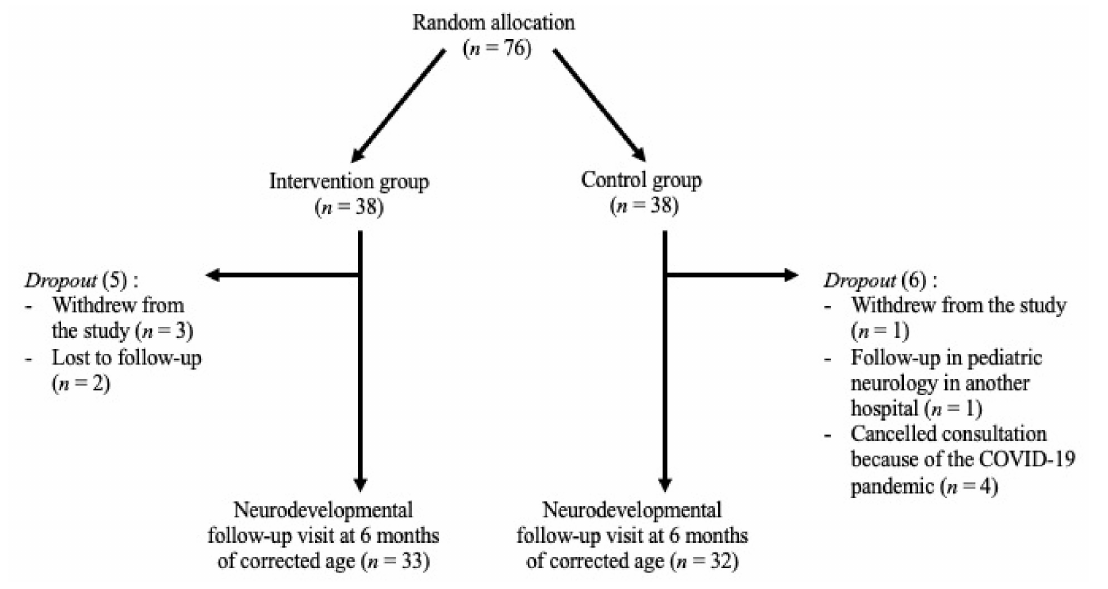
Figure 1. Flow chart of the